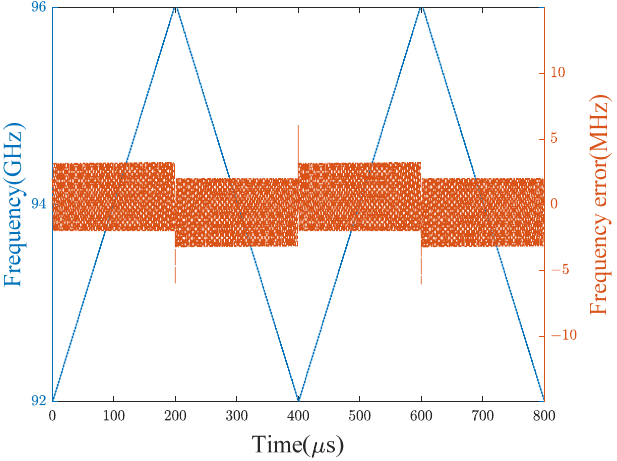
Figure 4. Simulation results of frequency and frequency error with time.